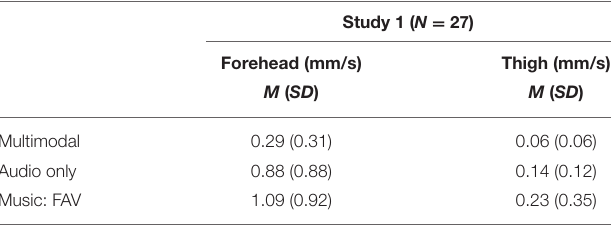
TABLE 5 | Mean speed of movement elicited by each category of musical stimulus.